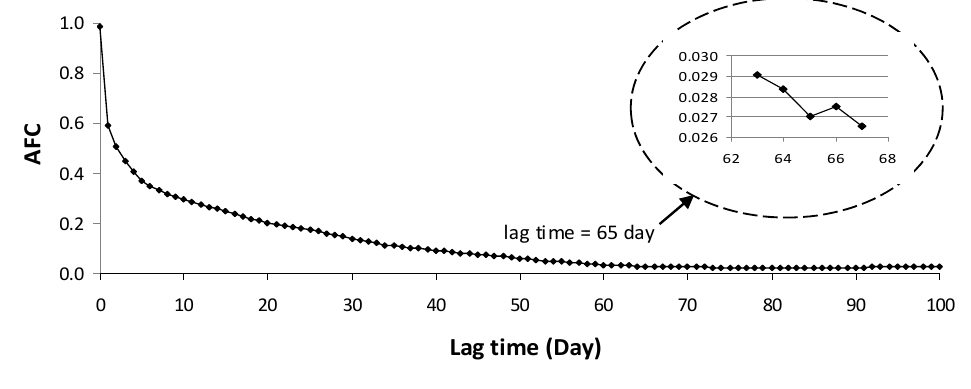
Fig.7 Autocorrelation Function – Sample Results for Orang